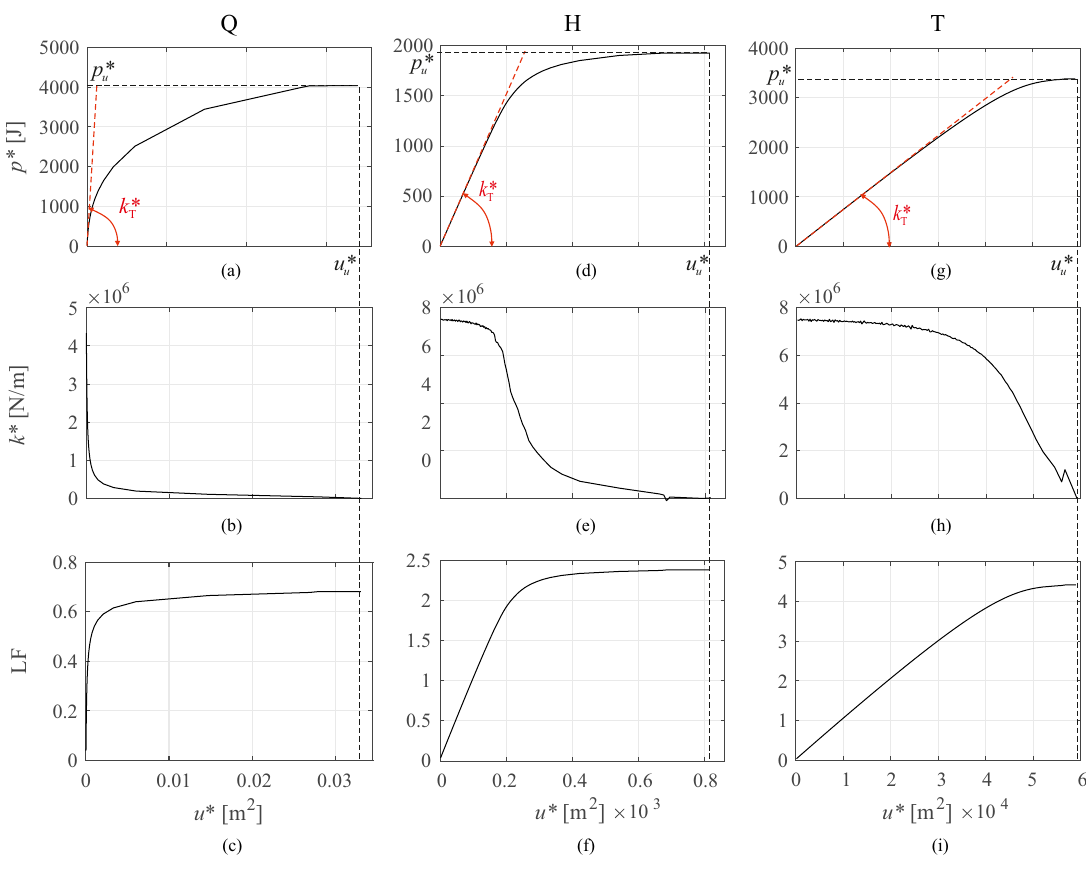
Figure 9: Structural Eigen-curves for Q, H and T gridshells with θ = 0